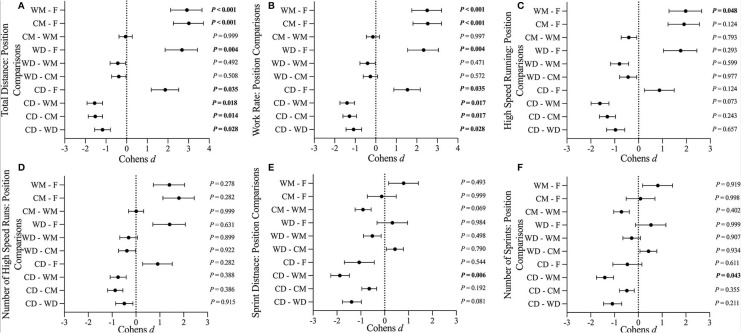
(A–F) Standardized differences in season average match play physical performance measures between playing positions: CD, central defenders; WD, wide defenders; CM, central midfielders; WM, wide midfielders; F, forwards. Data are presented as the standardized Cohens d effect size ± 95% CI.